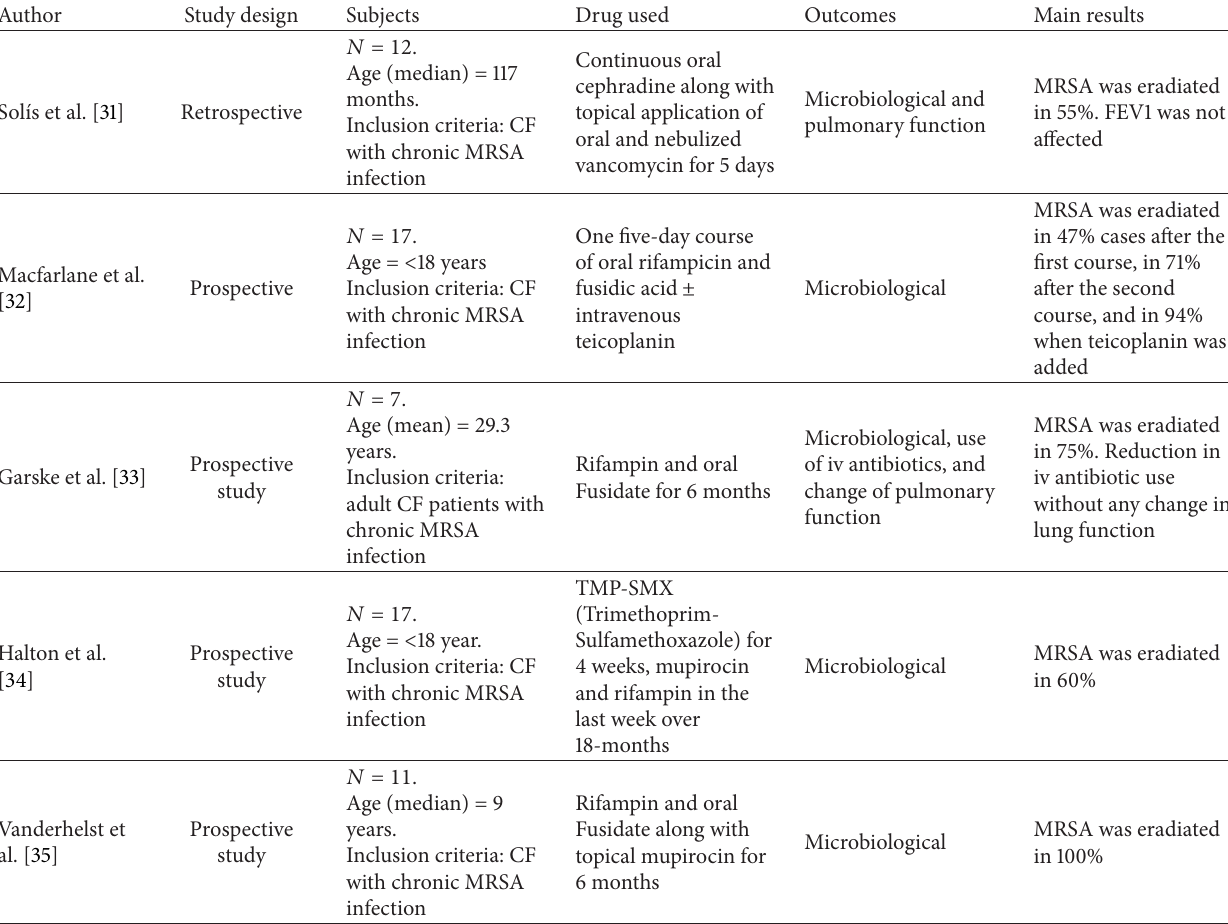
Table 6: Summary of trials for eradication of